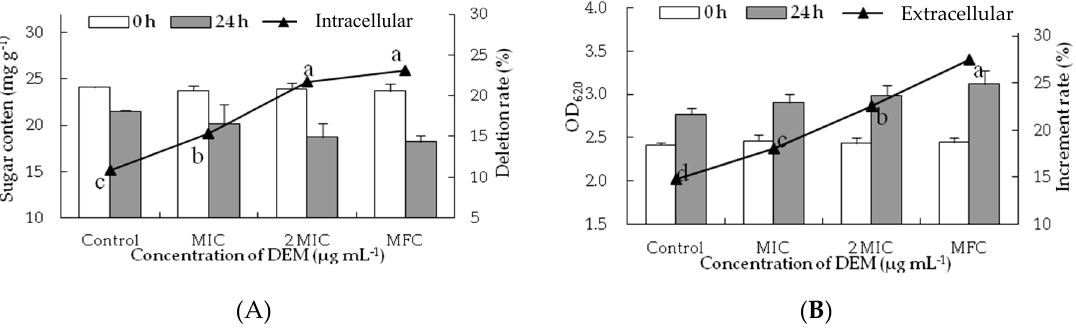
Figure 4. Effect of DEM on sugar content from intracellular ( A ) and extracellular ( B ) of P. italicum .